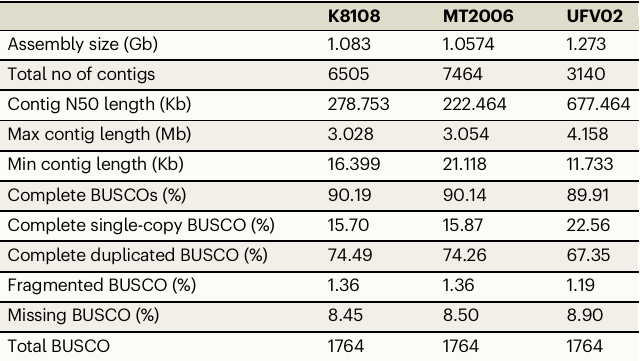
Table 1 | P. pachyrhizi genome assembly